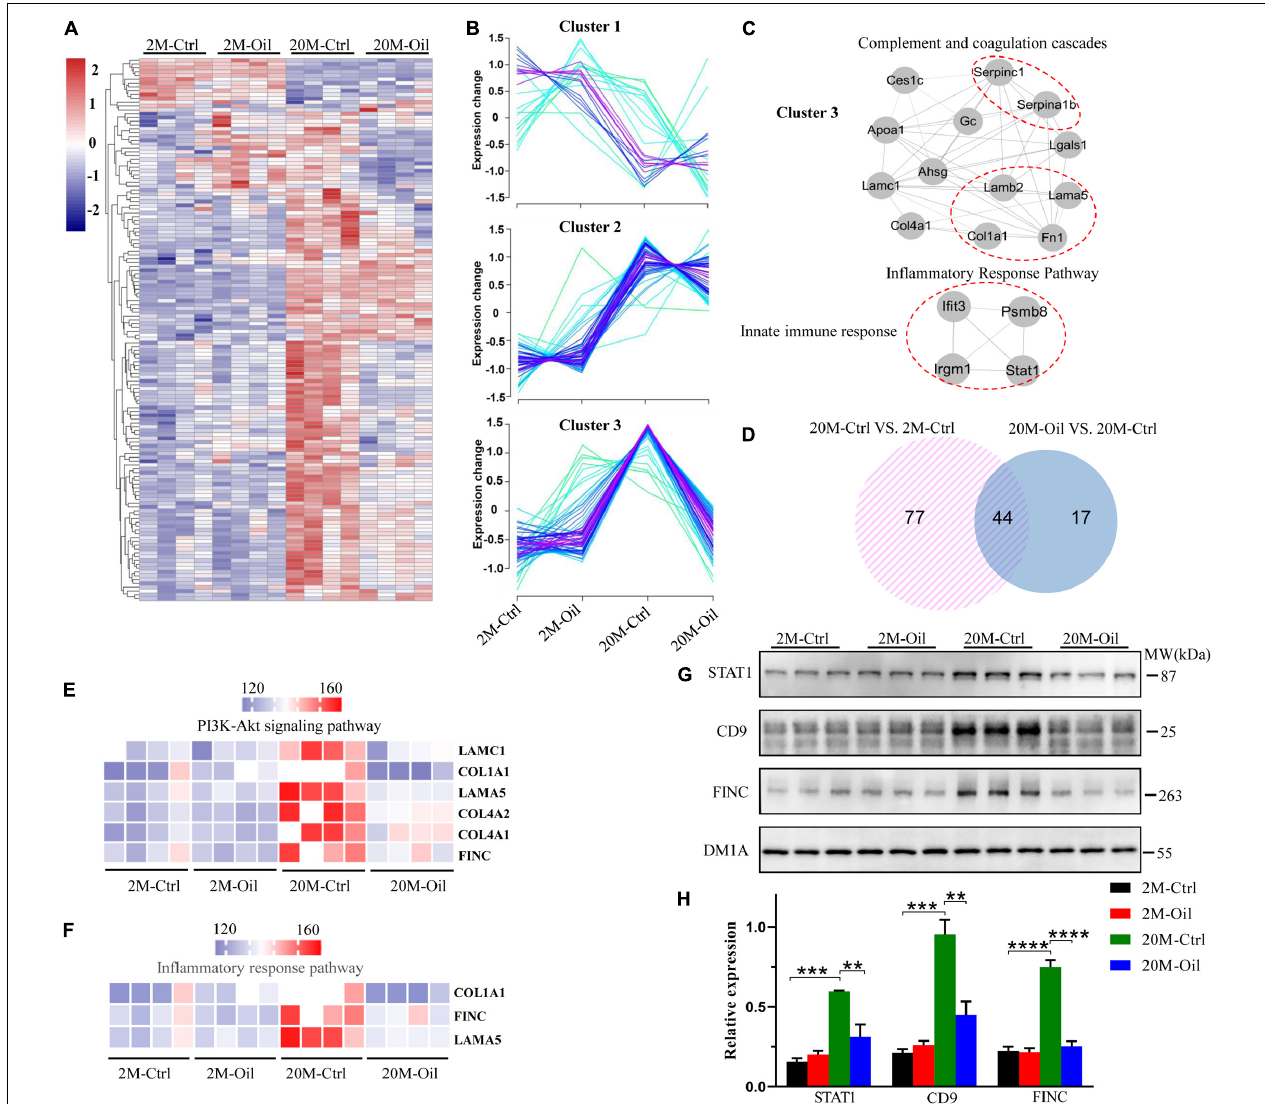
FIGURE 3 | Proteomic profiles of the hippocampus in acer truncatum seed oil treated aging mice. (A) The heatmap analysis for all DE proteins. (B) All DE proteins were analyzed into three clusters by RStudio. (C) Detected PPI modules in cluster 3. (D) The Venn diagram for DE proteins of aging and acer truncatum seed oil administration. DE proteins of acer truncatum seed oil treatment mice in PI3K-Akt signaling pathway (E) and inflammatory response pathway (F) . Validation of selected DE proteins by western blotting with the loading control (DM1A) (G,H) One-way ANOVA followed by Tukey’s multiple comparison tests, ** p < 0.01, *** p < 0.001, **** p < 0.0001. All data were expressed as mean ± SEM, n = 3